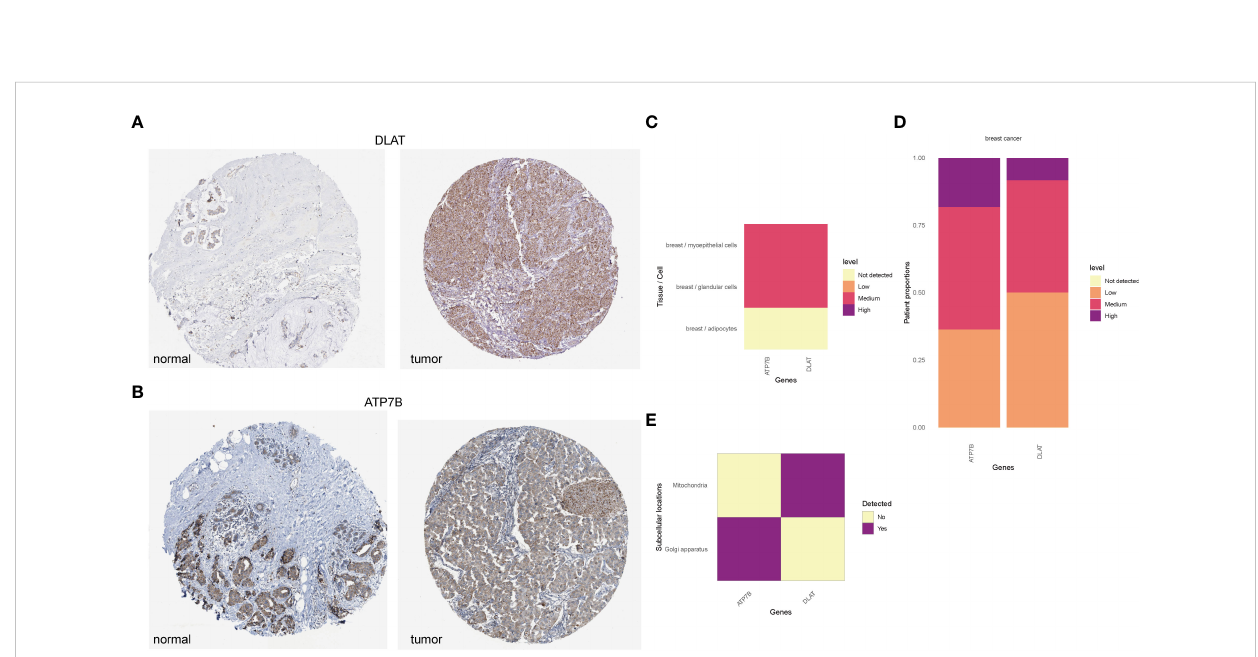
FIGURE 9 The protein expression of ATP7B and DLAT in BRCA tissues compared with non-tumor tissues in the HPA database. The protein expression of ATP7B (A) and DLAT (B) in breast cancer and normal tissues in the HPA database (http://www.proteinatlas.org) (40). (C) The expression of ATP7B and DLAT plotted according to cell types. (D) Column graphs showed the expression of ATP7B and DLAT in breast cancer samples. The subcellular localization of ATP7B and DLAT (C – E) was visualized by the R package “ HPAanalyze ” (41).